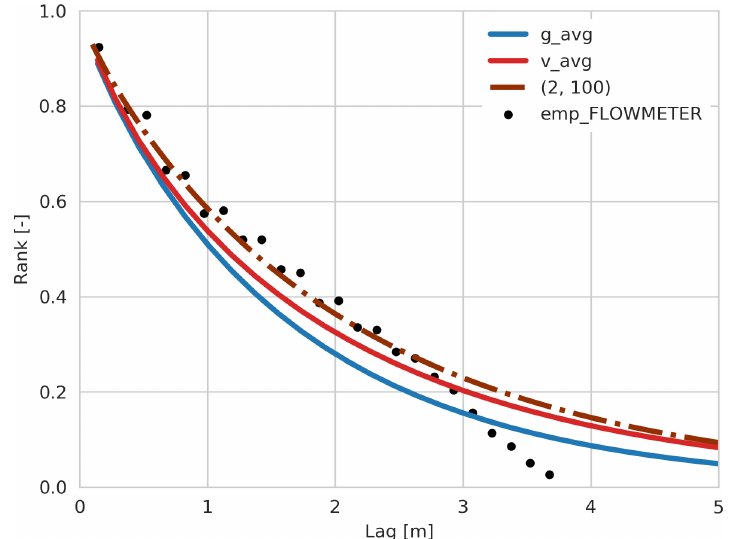
Figure 13. Comparison between the Gaussian copula parameter estimation with 2% left side detection limits (dash-dotted gray line with label (2, 100)), without detection limit (solid blue line with label g_avg), v-copula parameter estimation without censored threshold (sold red line with label v_avg) and empirical rank correlation of the flowmeter dataset in vertical direction (black dots with label